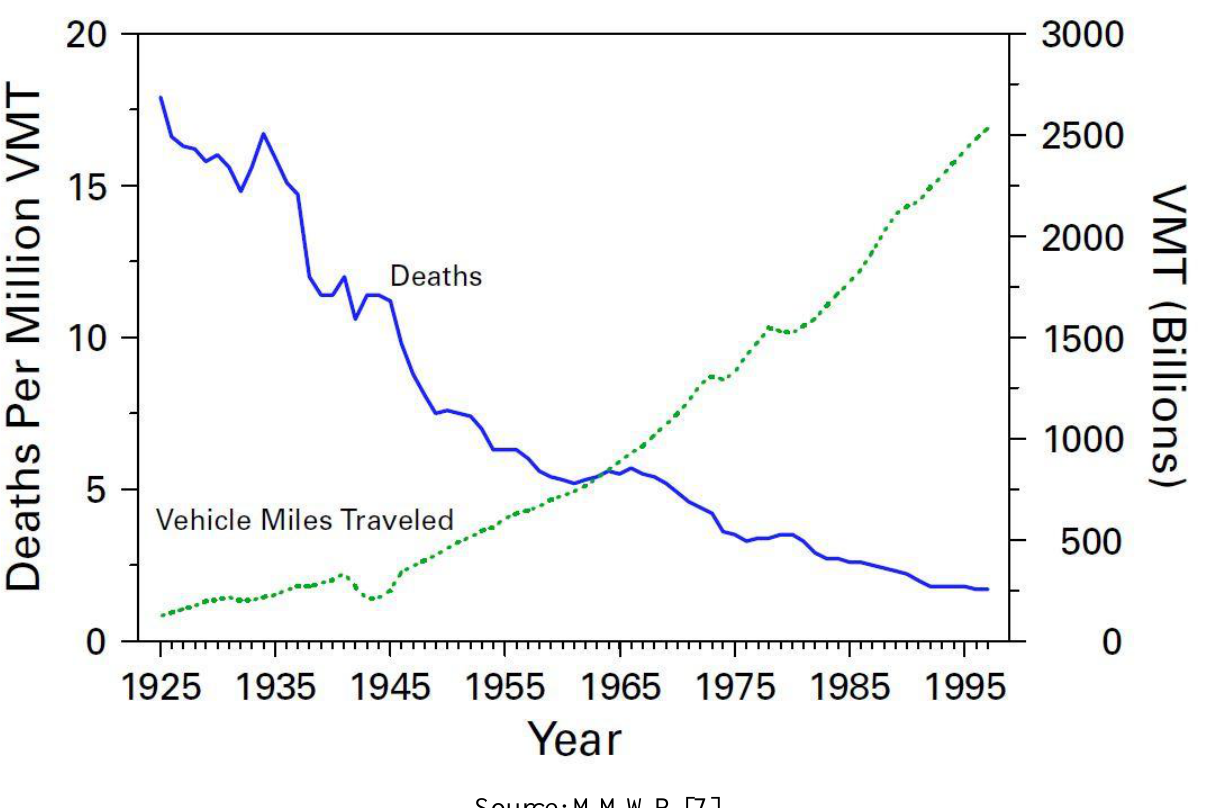
Figure 1. Motor-vehicle-related deaths per million vehicle miles traveled (VMT) and annual VMT, by year—United States, 1925–1997.